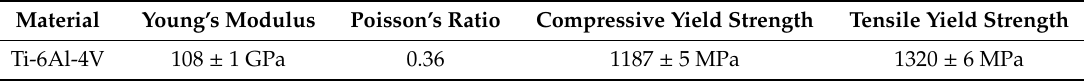
Figure 6. Meshing on an AC implant model for FEA, ( a ) solid and ( b ) cellular implant. Table 3. The material properties of Ti-6Al-4V used in the FEA [49].